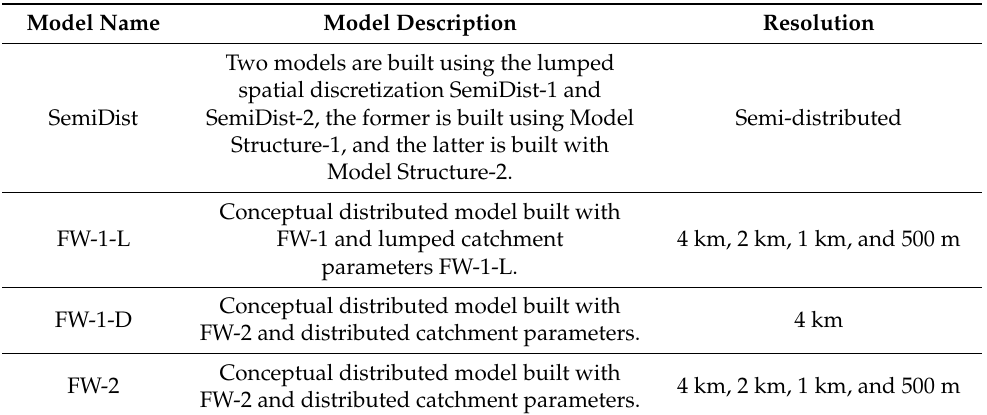
Table 3. Experimental